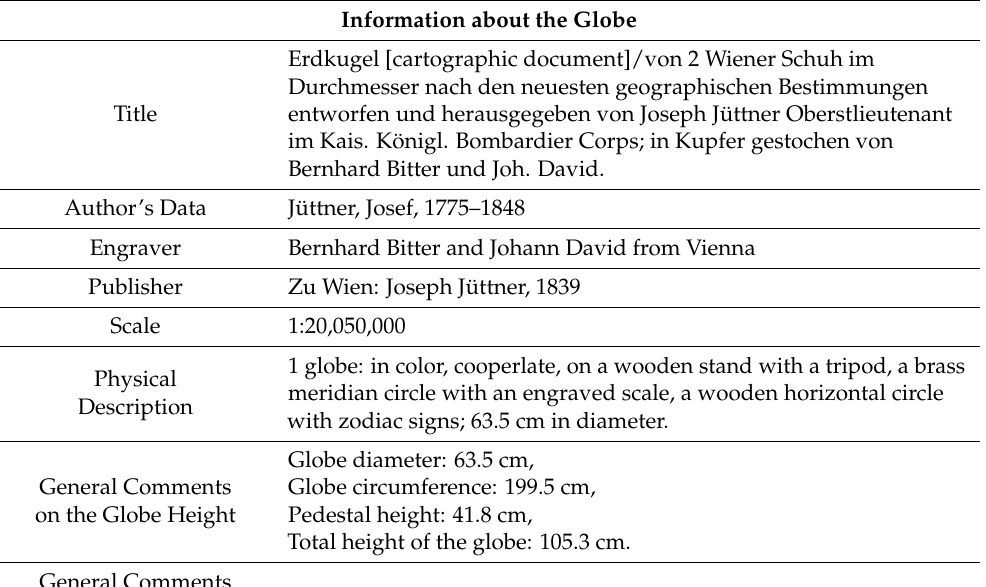
Table 5. Globe and 3D model metadata. Source: Map Collection of the Faculty of Science, Charles University. Information about the